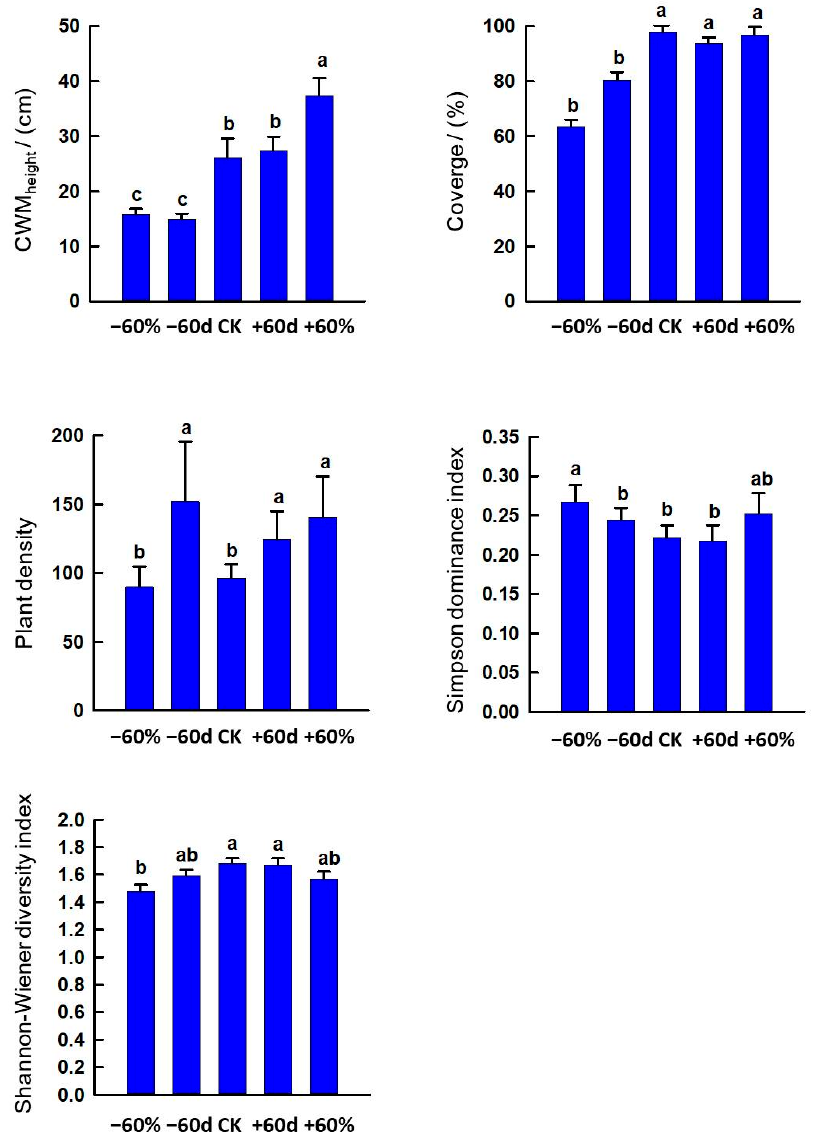
Figure 7. Effects of rainfall changes on vegetation characteristics in the sandy grassland. Note: Different little letters indicate significant differences among different rainfall treatments ( p < 0.05).